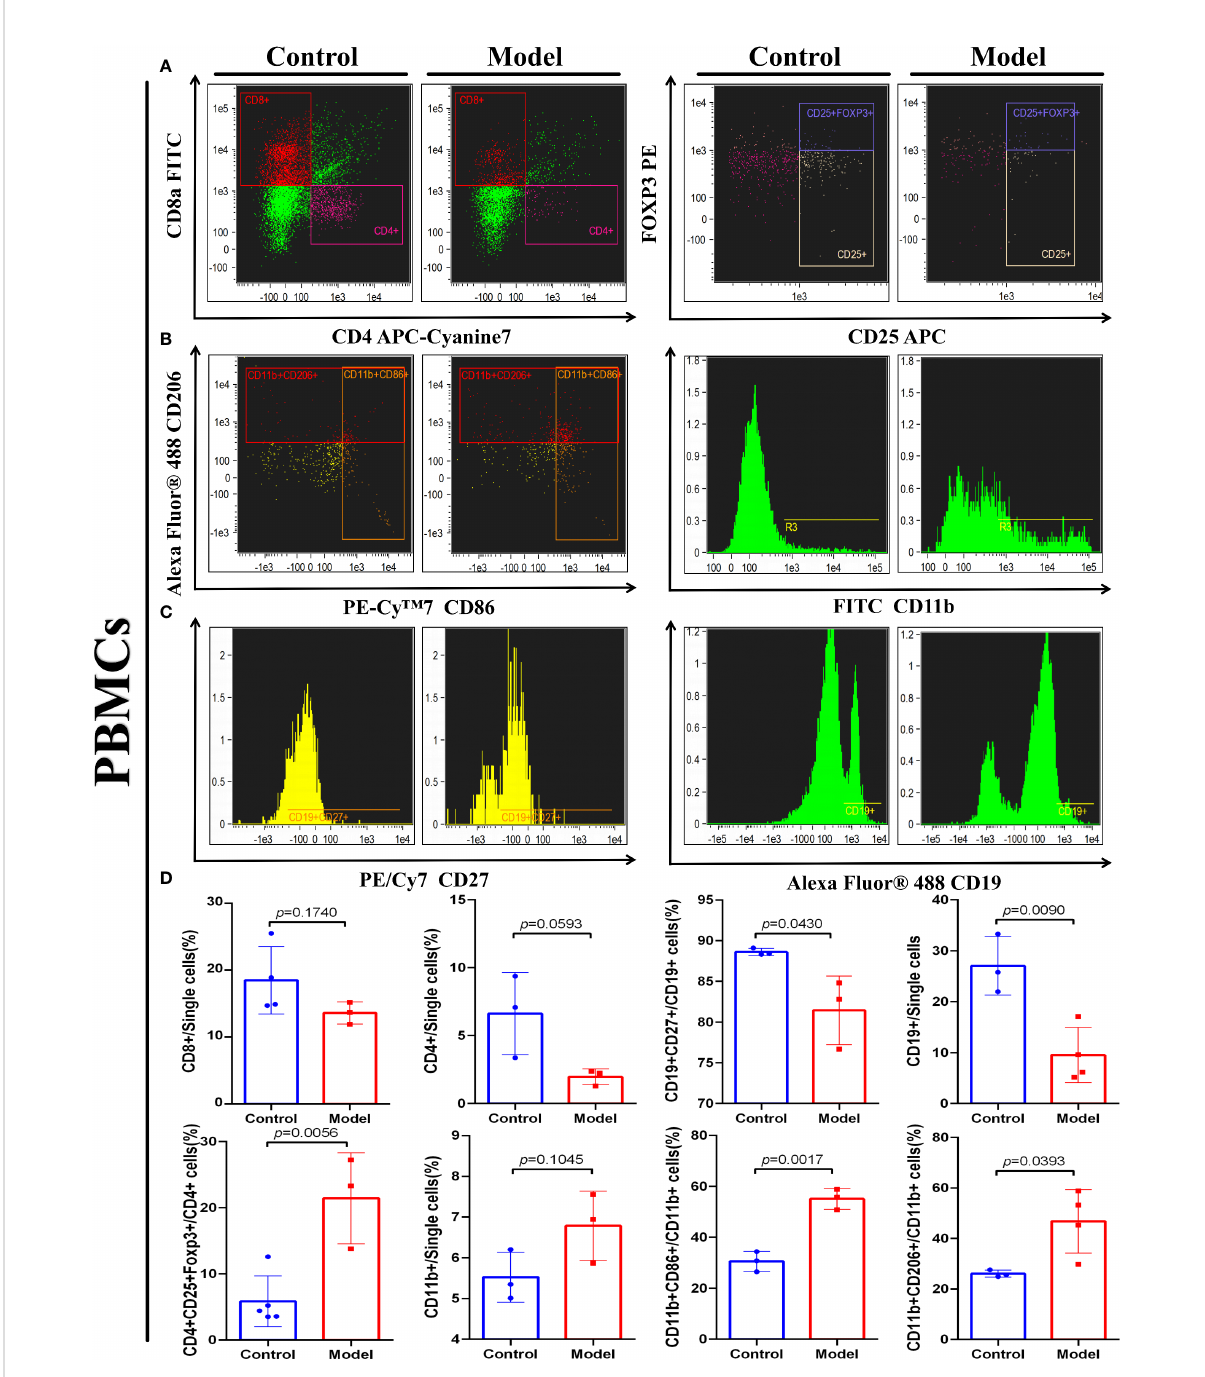
FIGURE 6 IRGPI-related immune cell discrepancy between CRC model mice with control mice. Flow cytometry determined the proportion of a series of immune-related cells that existed in murine peripheral blood. (A) T cells, (B) Macrophages, and (C) B cells. (D) Unpaired t -test analysis of the proportion of the immune-related cells: Cytotoxic T lymphocytes (CD8+), Helper T lymphocytes (CD4+) and Tregs cells (CD4+CD25+FOXP3+), B cells (CD27+), memory B cells (CD27+CD19+), Macrophages (CD11b+), M1 Macrophages (CD11b+CD86+), and M2 Macrophages (CD11b +CD206+) between control and the CRC model group. (Values are presented as mean ± SEM, n = 3 per